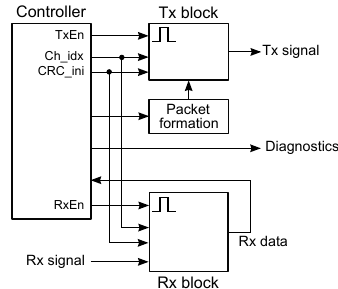
Figure 2. Block diagram of the BLE